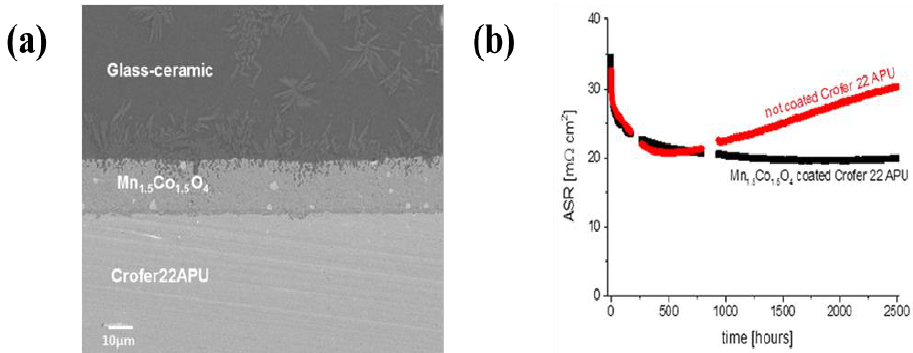
Figure 29. ( a ) SEM cross section image of the Mn 1.5 Co 1.5 O 4 coated Crofer22APU obtained at 50 V and 20 s and sintered at 1000 °C for 2 h in air; ( b ) Area Specific Resistance of uncoated and Mn 1.5 Co 1.5 O 4 coated Crofer22APU alloy tested at 800 °C under a 500 mA·cm − 2 load.